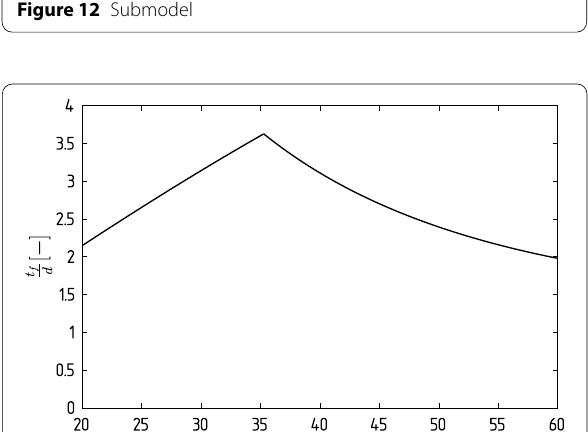
Figure 12 Submodel